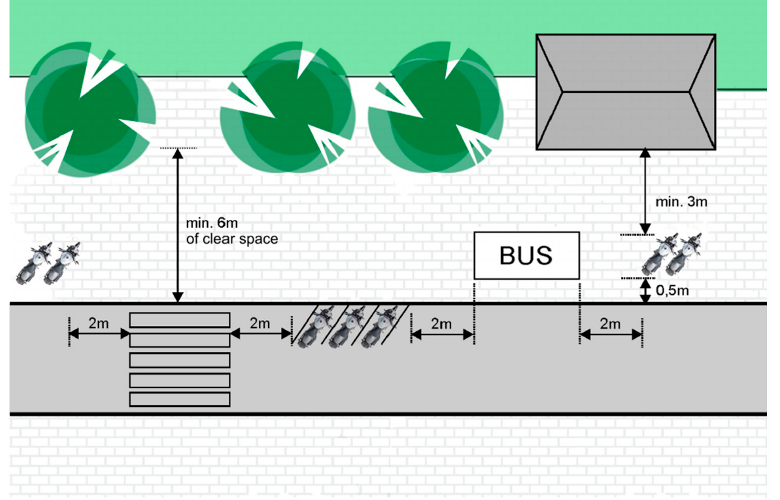
Figure 2. Basic parameters regarding the location of parking zones and parking of motorbikes and scooters in Barcelona (elaborated, based on Barcelona City Hall brochure: https://www.barcelona.cat/mobilitat/sites/default/files/Proposta%20fullet%c3%b2%20FINAL.pdf; accessed on 9 February 2021).